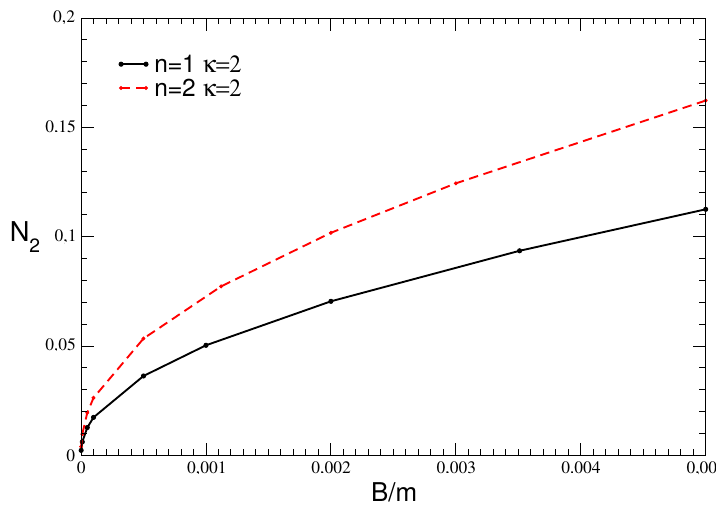
Figure 8. The two-body contribution N 2 vs. the binding energy B for the abnormal ( κ = 2, n = 1, and n = 2) states. (Adapted from